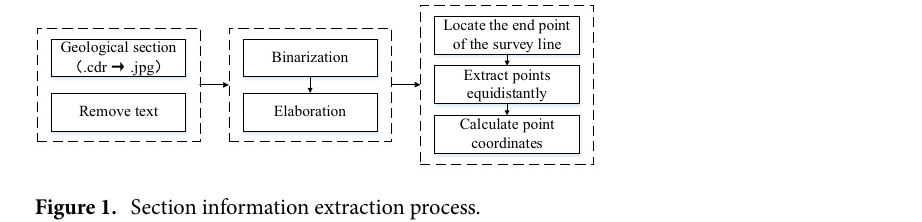
Figure 1. Section information extraction